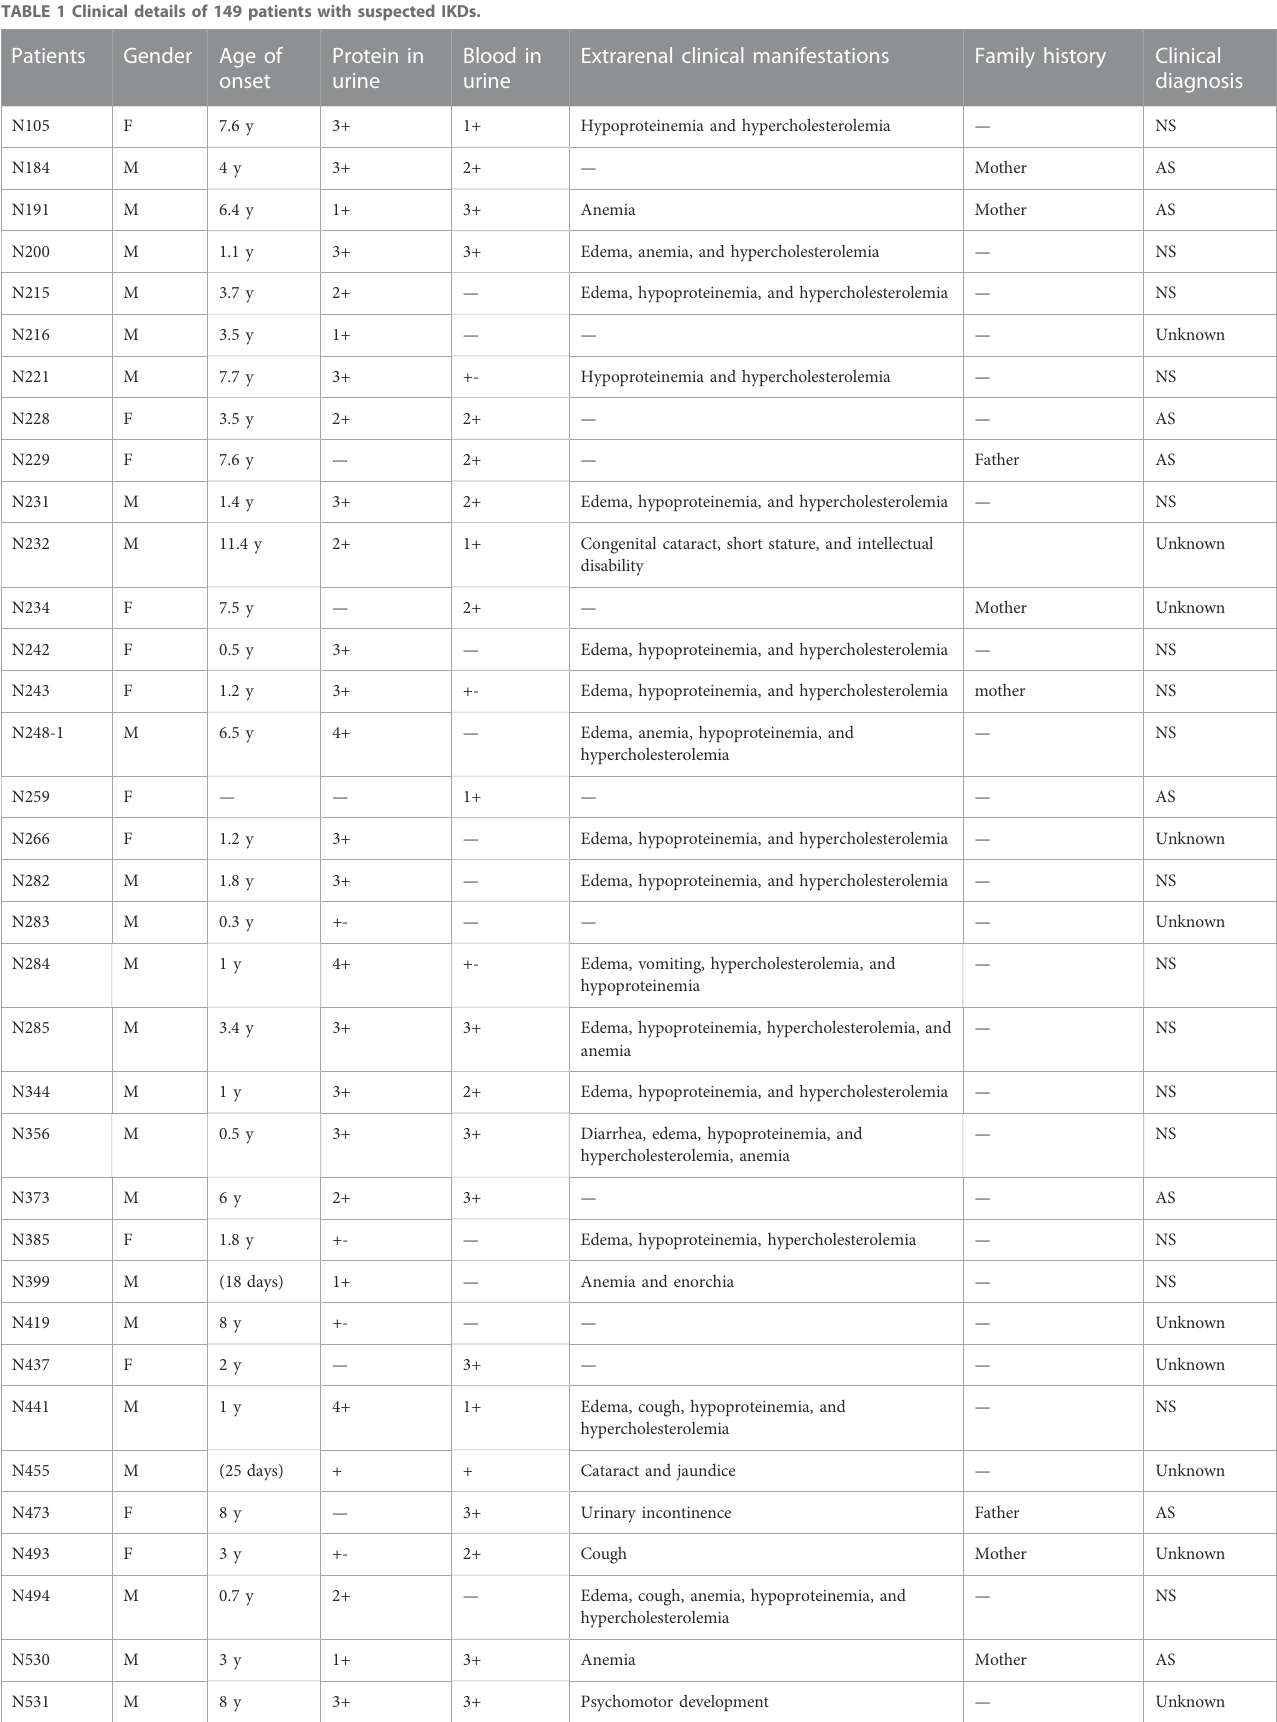
TABLE 1 Clinical details of 149 patients with suspected